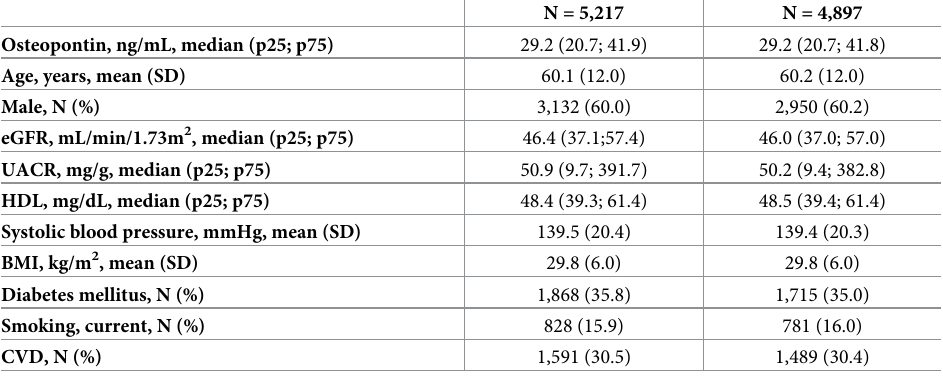
Table 1. Study sample characteristics of the complete GCKD study cohort (N = 5,217) and the GWAS analysis set (N = 4,897).